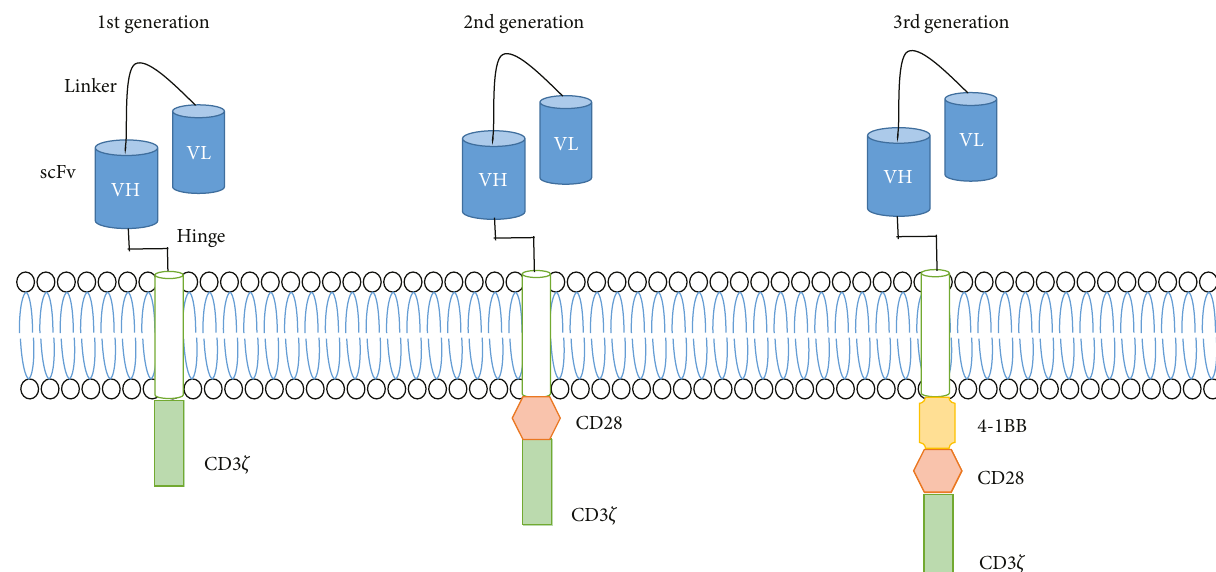
Figure 3: CAR T cell structure and design. Structure of fi rst-, second-, and third-generation engineered CAR T cells. Each generation consists of the variable heavy and variable light portion of the antibody, with a hinge domain and CD3 ζ . In each subsequent generation, an additional costimulatory molecule (i.e., CD28 or 4-1BB) is